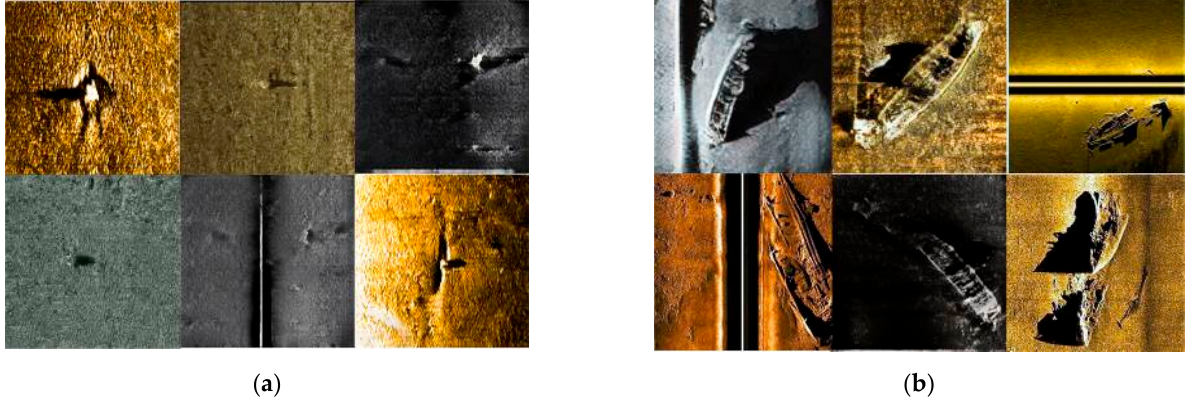
Figure 13. Examples of augmented underwater-target samples. ( a ) Mine target samples. ( b ) Ship- wreck target samples.